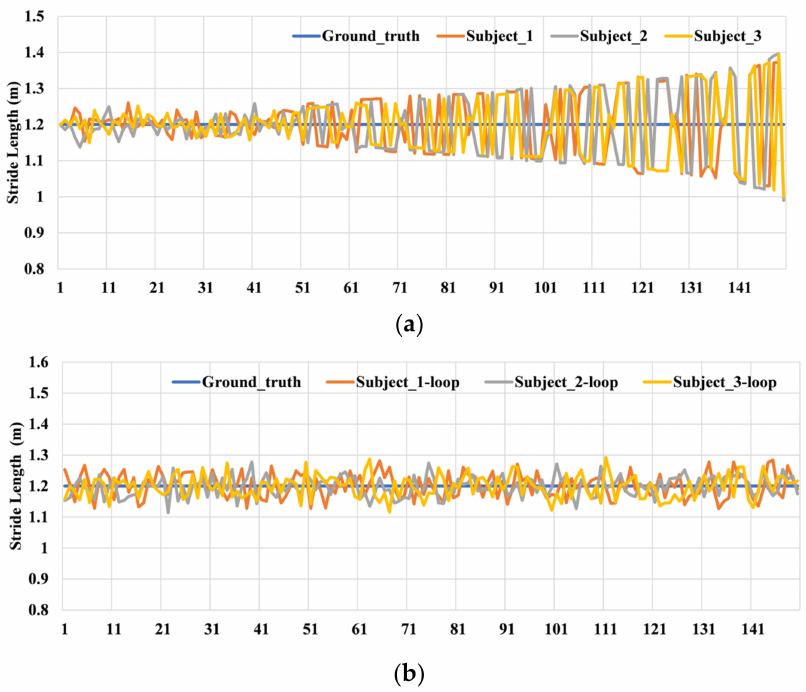
Figure 6. The stride-length estimation based on VIO without loop ( a ) and with loop detection ( b ).